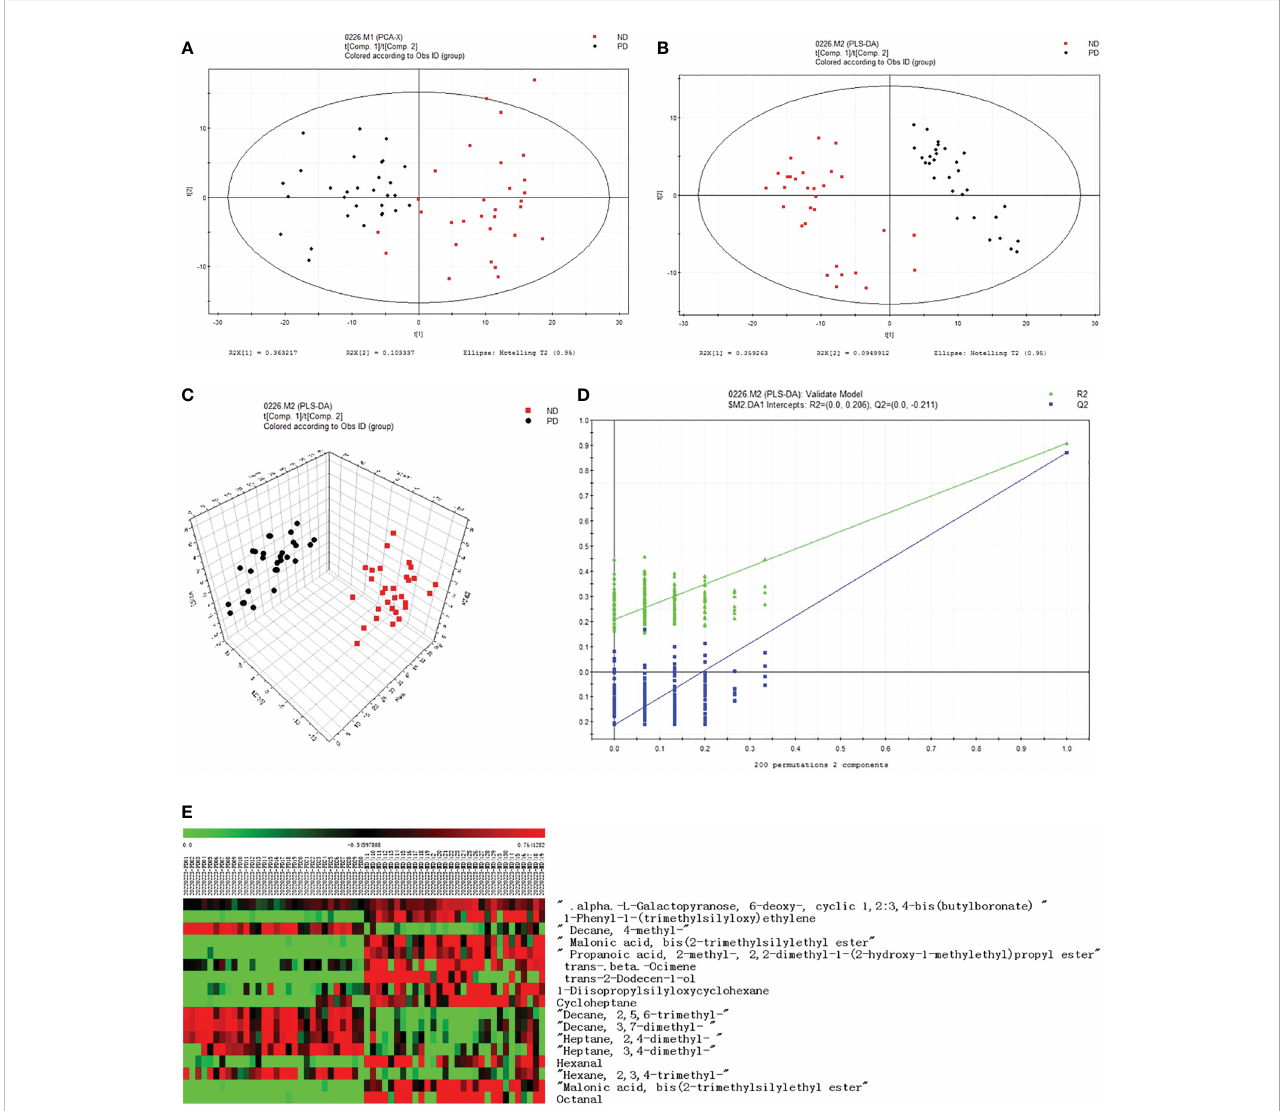
FIGURE 1 VOCs analysis chart. (A) PCA score plot, (R2X (1)=0.363217; R2X (2)=0.103337). The con fi dence level was the default of the software SIMCA-P 11.5, and its threshold was 95%. (B) PLSDA score plot, (R2X (1)=0.359263; R2X (2)=0.0949912). (C) PLS-DA score plot. (D) PLS-DA validation plot intercepts, R2= (0.0,0.206), Q2=(0.0,-0.211). (E) Heat map of two groups of different